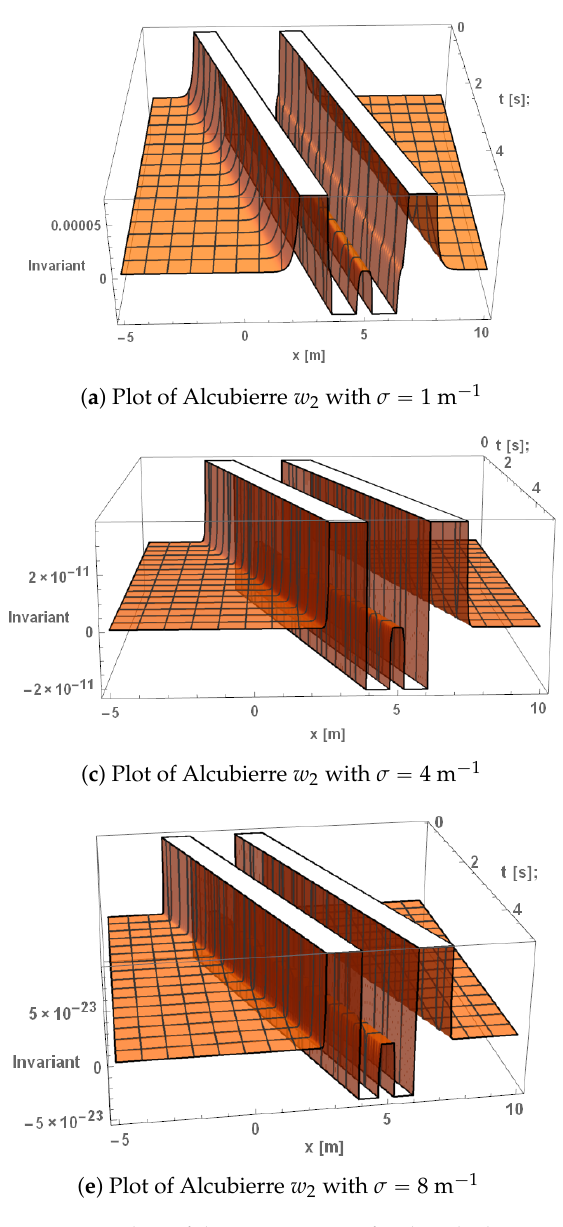
Figure A4. Plots of the w 2 invariants for the Alcubierre warp drive while varying skin-depth. The radius and velocity were chosen as ρ “ 1 m and v s “ 1 c to match the parameters Alcubierre originally suggested in his paper